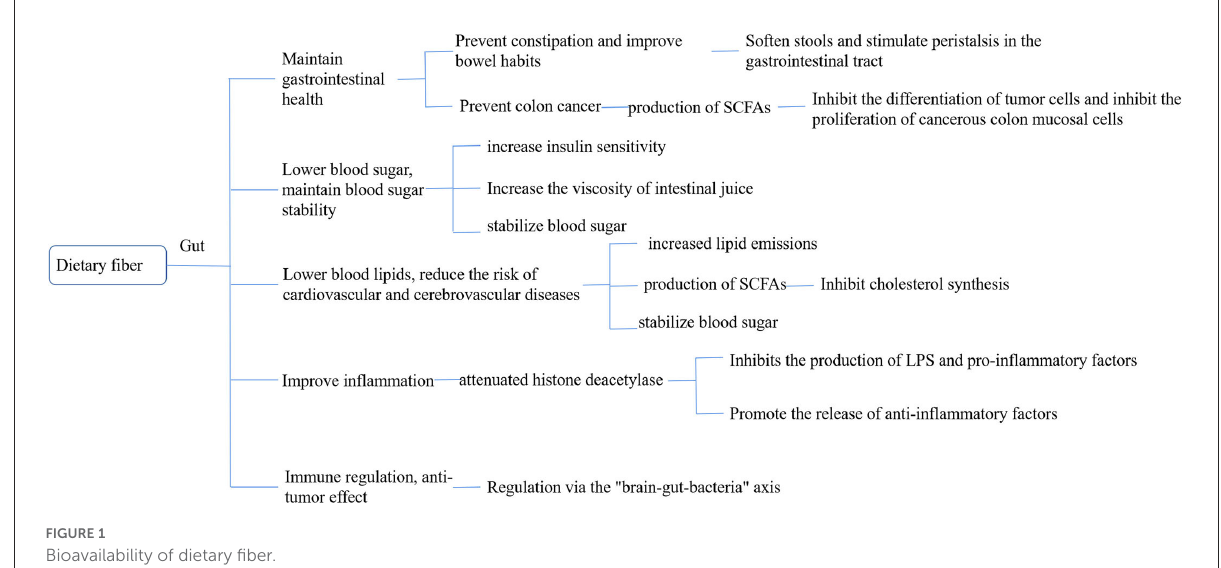
FIGURE1 Bioavailability of dietary